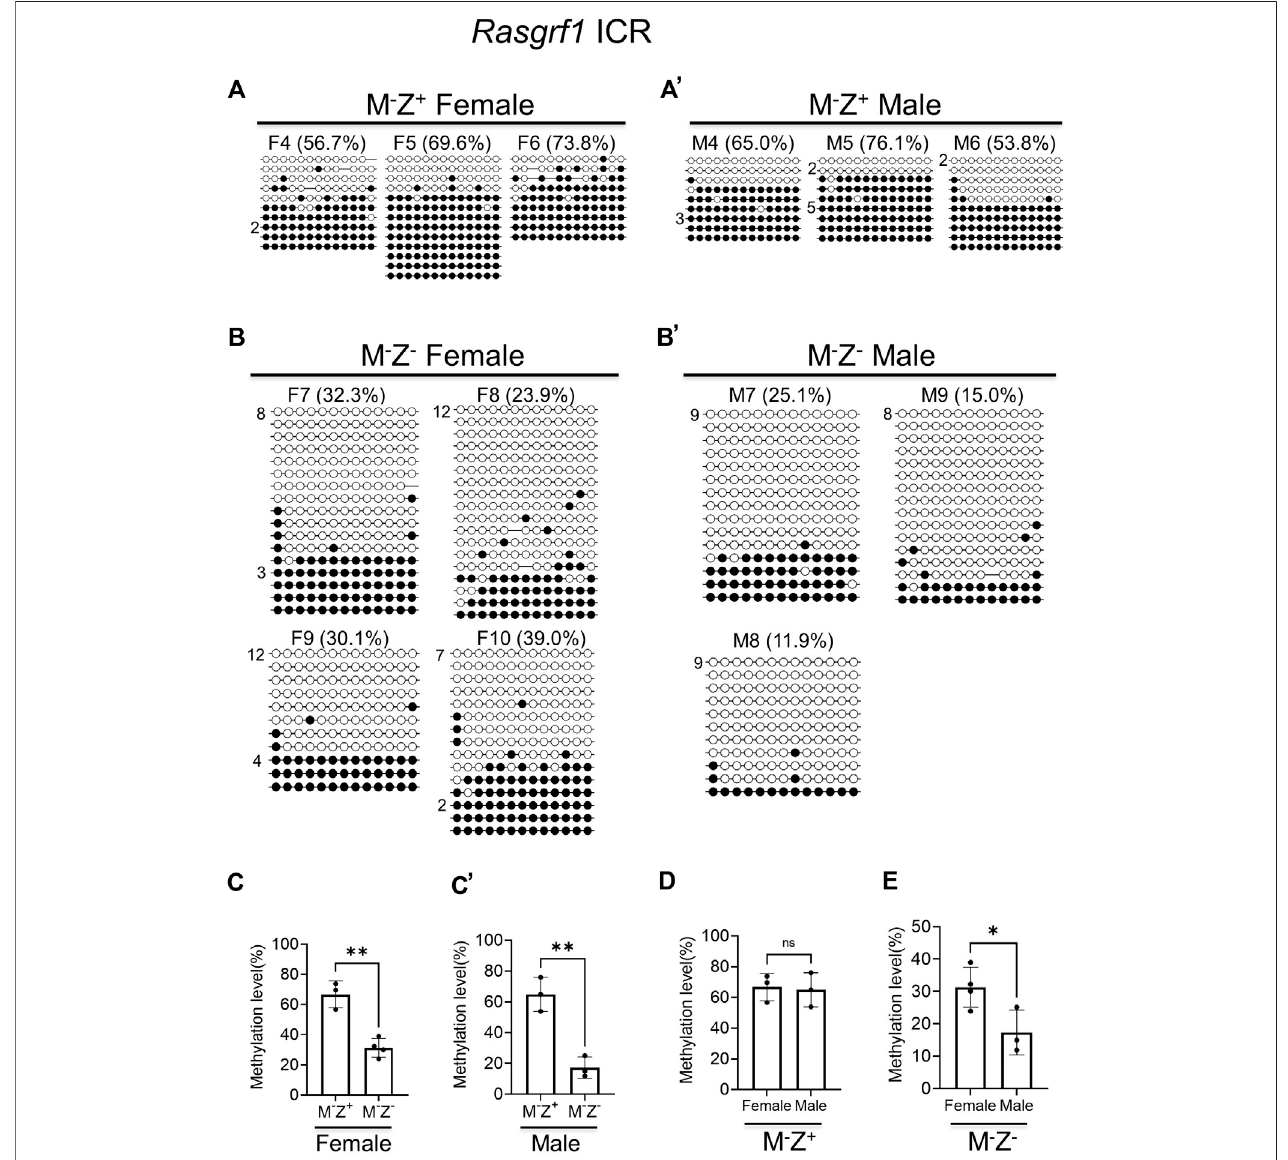
FIGURE 3 | DNA methylation at the Rasgrf1 ICR was more severely lost in the male maternal – zygotic mutant embryos than in the female ones based on bacterial colonybisul fi tesequencinganalysis.GenomicDNAsampleswereisolatedfromatleastthreefemaleormale Zfp57 − /+ (M − Z + )and Zfp57 − / − (M − Z - )E13.5embryosderived fromthetimedmatingbetween Zfp57 homozygousmutantfemalemiceandheterozygousmalemice.Theyweresubjectedtobisul fi temutagenesisfollowedbybacterial colonysequencingofthe321-bpbisul fi tePCRproductofthe Rasgrf1 ICRregion.Theunconvertedcytosine (C) residueswereusedtodeterminetheuniqueclones for the bisul fi te colony sequencing. Each row represents a unique clone, with the fi lled black circles for methylated CpG sites and un fi lled white circles for unmethylated CpG sites. The number in front of a unique clone shows the number of sequenced non-unique clones containing the same sequence that cannot be distinguished by unconverted (C) residues.ThepercentageofDNAmethylationin (A,B ’ ) wascalculatedbasedonthenumberofmethylatedCpGsitesdividedbythetotalnumberofCpG sites for the sequenced unique clones of the bisul fi te PCR product. Two-tailed Student ’ s t test was used for statistical analysis of DNA methylation level differences between two different genotypes of the same gender (C – C ’ ) or within the same genotype between males and females (D,E) . Statistical signi fi cance: *, p < 0.05; **, p < 0.01;and***, p < 0.001. (A) ThreeM − Z + femaleembryos(F4 – F6). (A ’ ) ThreeM − Z + maleembryos(M4 – M6). (B) FourM − Z - femaleembryos(F7 – F10). (B ’ ) ThreeM − Z - male embryos(M7 – M9). (C) DNAmethylationatthe Rasgrf1 ICRwassigni fi cantlyreducedinfourM − Z - femaleembryoscomparedwiththreeM − Z + femaleembryos. (C ’ ) ,DNA methylation at the Rasgrf1 ICR was signi fi cantly reduced in the three M − Z - male embryos compared with three M − Z + male embryos. (D) DNA methylation at the Rasgrf1 ICR was similar comparing three M − Z + female embryos with three M − Z - male embryos. (E) DNA methylation at the Rasgrf1 ICR was signi fi cantly reduced in the three M − Z - male embryos compared with four M − Z - female embryos.